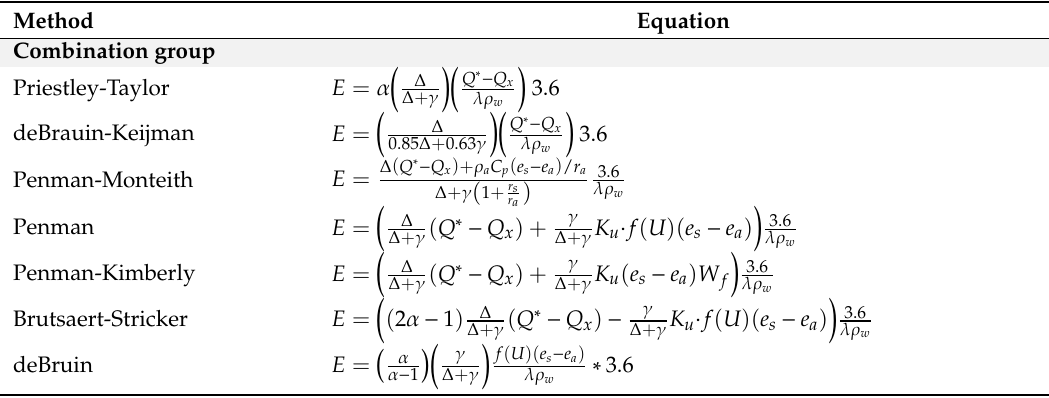
Table 1. Evaporation estimation methods (mm h − 1